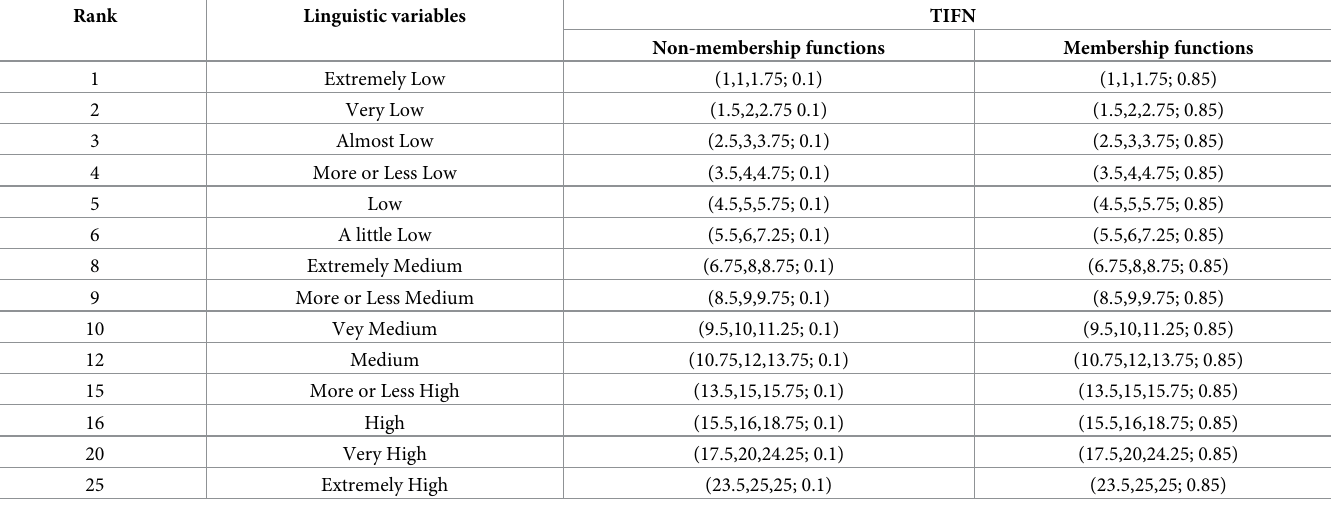
Table 3. Linguistic values and the parameters of membership and non-membership functions of TIFNs for the output variable and risk level. Rank Linguistic